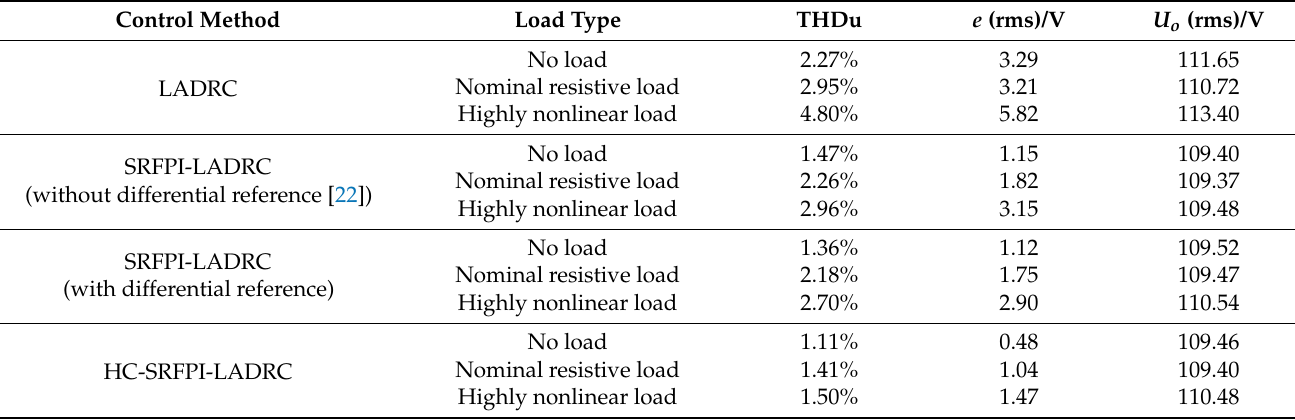
Table 4. Measuring results of different methods under different load